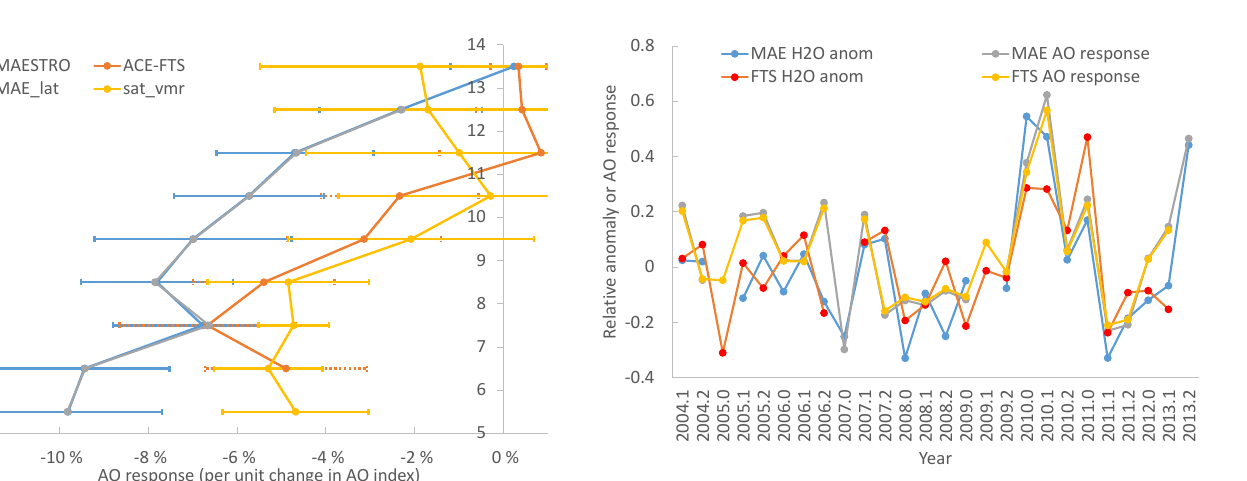
Figure 9. Analogous to Fig. 8, but for northern high-latitude wa- ter vapour in response to the Arctic oscillation. Error bars display ± 1 standard error of the fitting coefficient for the AO index ob- tained by linear regression. At 5.5km, the response of ACE-FTS is not shown since it has a standard error of >100% and the sample size decreases significantly.